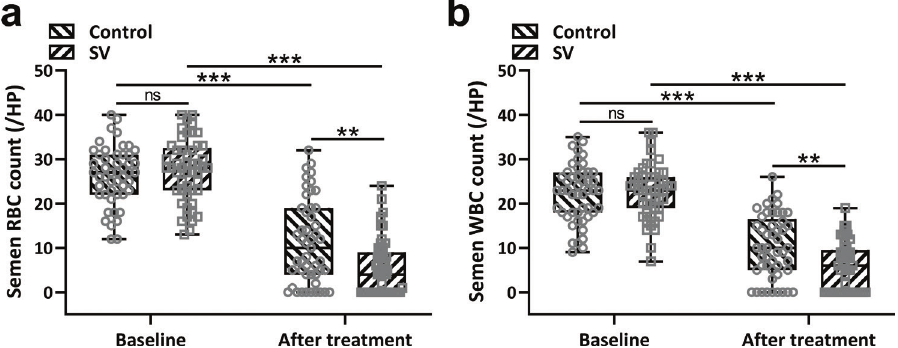
Fig. 1 . Comparisons of red blood cell count (a) and white blood cell count (b) in semen between the two groups before and after treatment. N = 49 for each group. Data were shown with box plot. ** P < 0.01, *** P < 0.001, and ns means no significance. Two- way ANOVA followed Turkey’s multiple comparisons test.